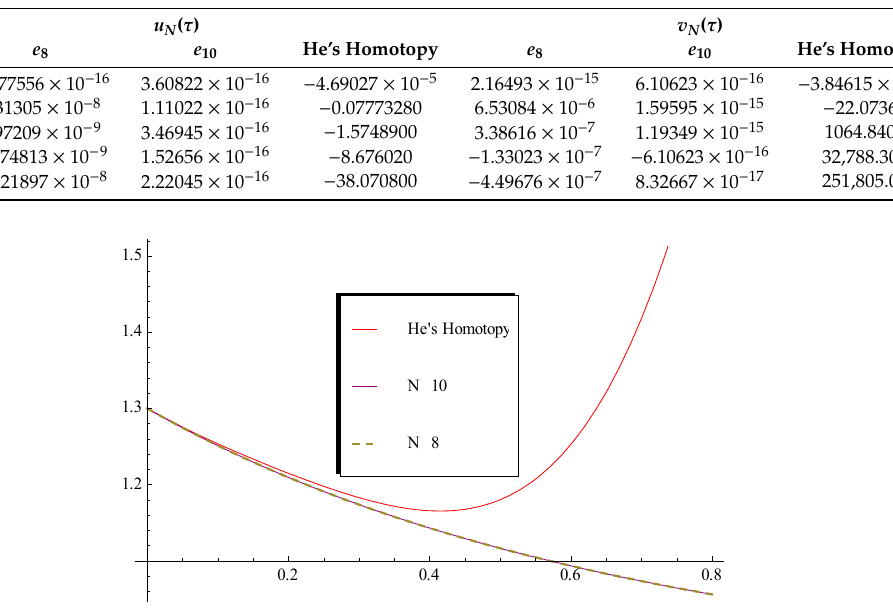
Table 14. The residual errors for RC collocation method and He’s Homotopy perturbation method.